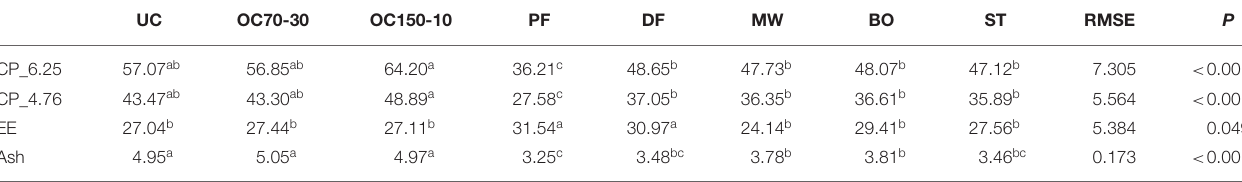
TABLE 1 | Proximate compositions (on dry matter, %) of uncooked larvae and larvae cooked with different techniques. UC OC70-30 OC150-10 PF DF MW BO ST RMSE P